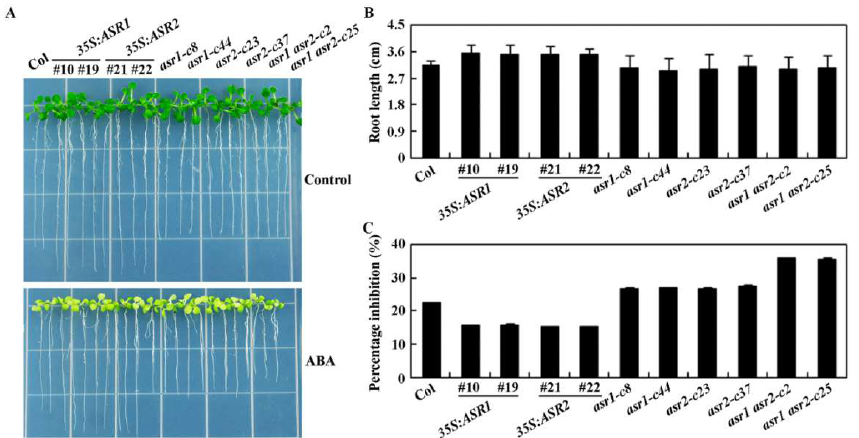
Figure 6. Primer root length and effects of ABA on root elongation of the Col wild type, the 35S : ASR1 and 35S : ASR2 transgenic plants, the asr1 and asr2 single and the asr1 asr2 double mutants. ( A ) Seedlings of the Col wild type, the 35S : ASR1 and 35S : ASR2 transgenic plants, the asr1 and asr2 single and the asr1 asr2 double mutants on plates with or without ABA. Sterilized seeds of the Col wild type, the 35S : ASR1 and 35S : ASR2 transgenic plants, the asr1 and asr2 single and the asr1 asr2 double mutants were sown on 1/2 MS plates and kept at 4 ◦ C in dark for 2 days, then transferred to a growth room and placed vertically for 4 days. The seedlings were then transferred to new plates with or without 10 µ M ABA, and grown vertically for an additional 10 days, and then pictures were taken. ( B ) Quantitative analysis of the primary root length of the Col wild type, the 35S : ASR1 and 35S : ASR2 transgenic plants, the asr1 and asr2 single and the asr1 asr2 double mutants. Root length on plates without ABA were measured and calculated. Data represent the means ± SD of 20 seedlings. ( C ) Inhibition of root elongation by ABA. Length of new elongated roots on plates with or without ABA was measured, and percentage of inhibition was calculated. Data represent the means ± SD of 20 seedlings.